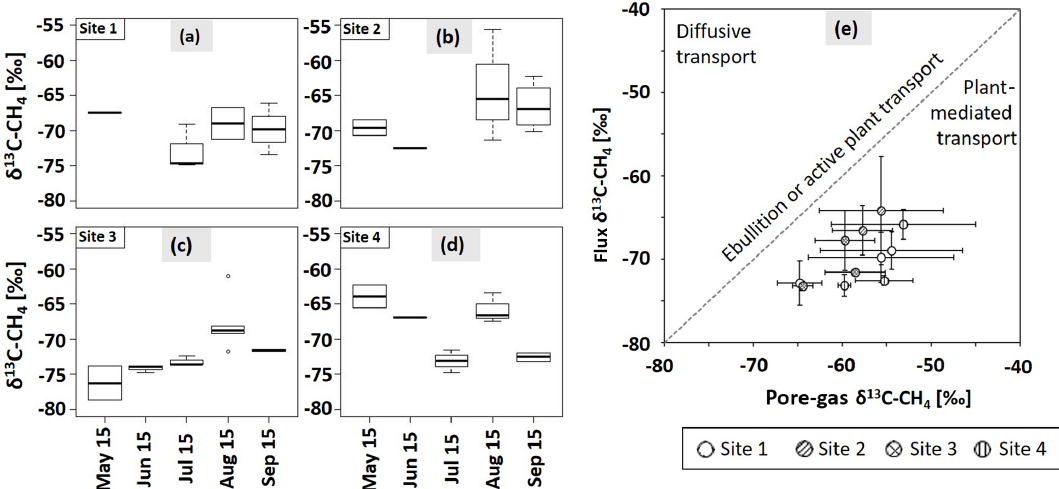
Figure 6. The δ 13 C–CH 4 signatures (‰) of CH 4 fluxes from May to September for sites 1 (a) , 2 (b) , 3 (c) , and 4 ( d , n = 1–4). In July 2015, sampling at site 2 was not possible. Bold lines are the median, boxes show the 25th and 75th percentile, and whiskers indicate minima and maxima within 1.5 times the interquartile range. Single points show outliers. (e) Dominant flux pathway of CH 4 according to Horni- brook (2009). Empty circles: site 1, circles with diagonal lines: site 2, circles with crosses: site 3, circles with vertical lines: site 4. Dashed line represents transport via ebullition or active plant transport without any isotopic fractionation. Values are means of pore-gas samples from 5–35cm of depth and chamber flux measurements. Graphs show mean values and SDs from three replications at each site ( n =